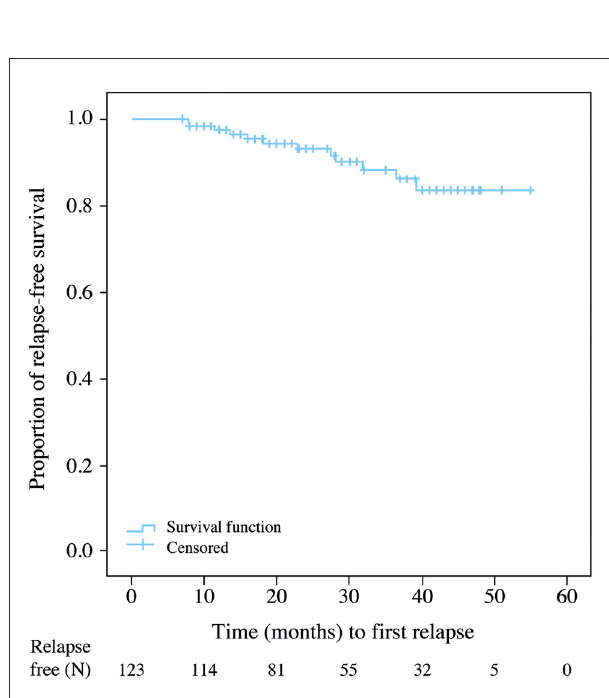
FIGURE2 Kaplan–Meier estimates of time to first relapse during alemtuzumab treatment.